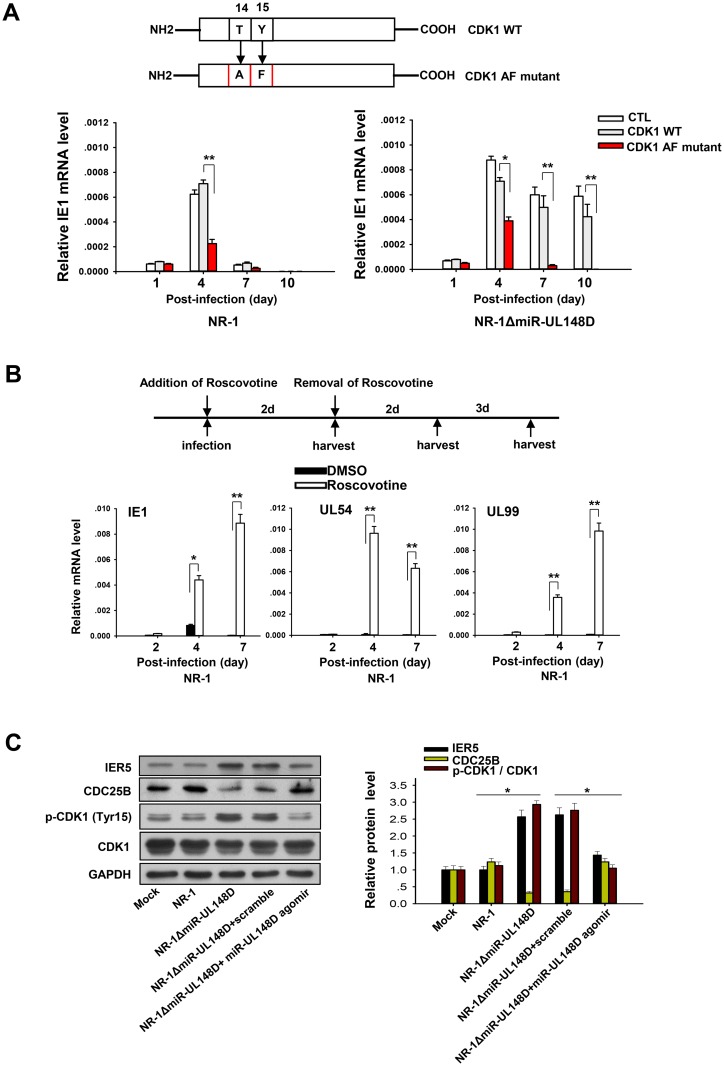
miR-UL148D silences IE1 by activating CDK1.(A) Overexpression of constitutively activated CKD1 efficiently inhibited IE1 transcription. Upper panel: construction of CDK1 WT and CDK1 Mut lentiviruses. CDK1 Mut is constitutively activated through the mutation of two phosphorylation sites. Kasumi-3 cells were infected with lentivirus expressing CDK1 WT or CDK1 Mut 48 h before being subjected to NR-1ΔmiR-UL148D or NR-1 infection over a 10-day time course. An empty-backbone lentivirus was used as a control. The infected cells were harvested at the indicated time points to extract total RNA for RT-qPCR analysis of IE1. (B) CDK1 inhibition induced viral lytic gene transcription in the NR-1-infected Kasumi-3 cells. NR-1-infected Kasumi-3 cells were treated with Roscovitine at concentration of 2 μM for 48 hours and harvested for RT-qPCR analysis of IE1, UL54 and UL99 on the indicated time points along a 7-day time course. (C) Western blot analysis of IER5, CDC25B, p-CDK1 (Tyr15) and CDK1 expression in Kasumi-3 cells infected with NR-1, NR-1ΔmiR-UL148D, NR-1ΔmiR-UL148D (co-incubation with scrambled oligonucleotide) or NR-1ΔmiR-UL148D (co-incubation with miR-UL148D agomir) at 10 dpi. Left panel, representative western blot. Right panel, semi-quantitative analysis. Values are shown as the mean ± SEM (n = 3). **, P<0.01.